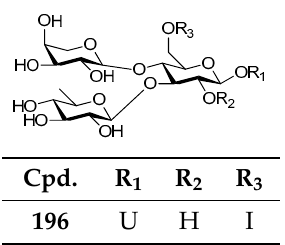
Figure 29. Structure of compound 196 .